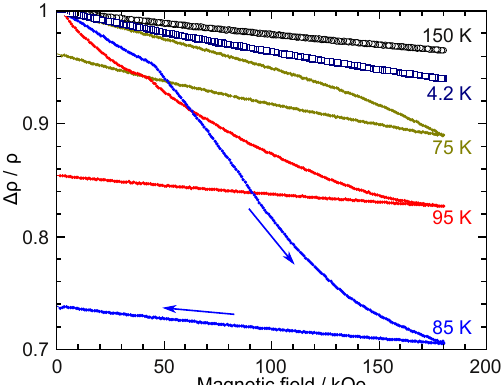
Figure 6. Change in the electric resistivity against magnetic fields up to 180 kOe. At 4.2 and 150 K, only intrinsic magnetoresistance is seen. However, a magnetic-field-induced transition is found at other temperatures. A maximum of about 30% of extrinsic magnetoresistance is observed at 85